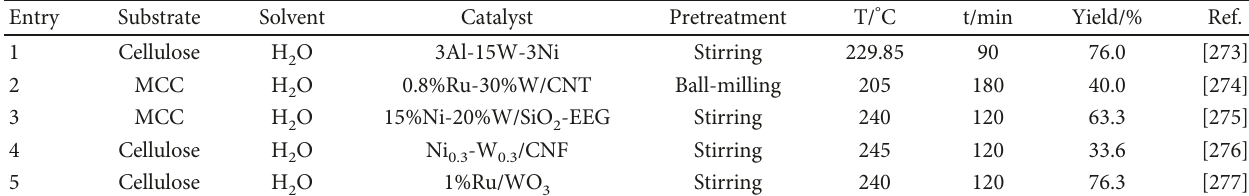
Table 3: Overview of EG yields from the conversion of cellulose in the typical catalytic